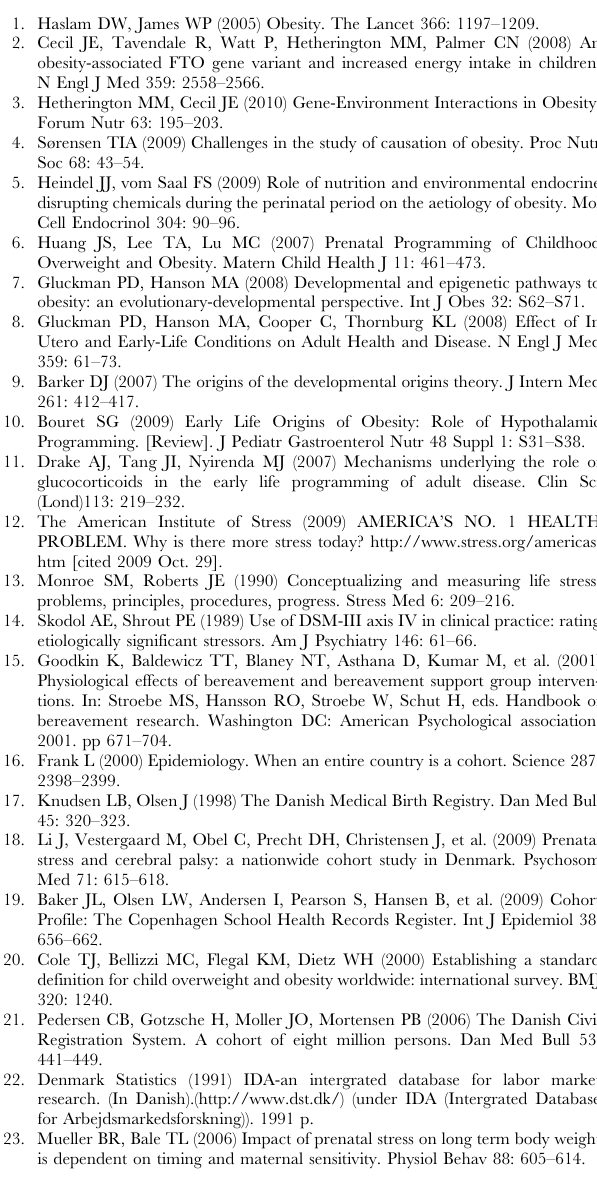
Table S1 Baseline characteristics of the study